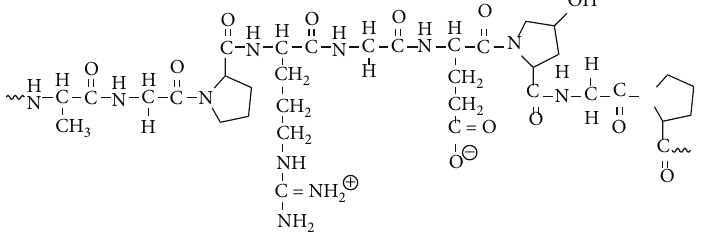
Figure 22: (left) SEM micrograph of carvacrol in pectin-alginate matrix microcapsules (3000 × magni fi cation) and (right) release of carvacrol from pectin-alginate microcapsules in potassium phosphate bu ff er solution (PBS, pH = 7 : 4 ) at 37 ° C [69].